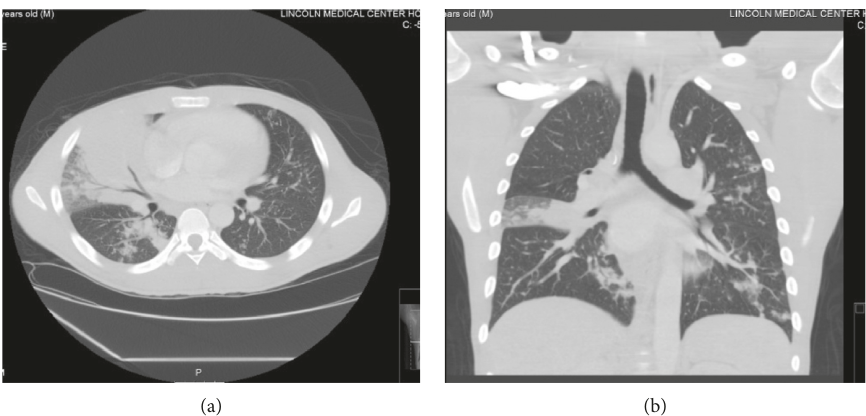
Figure 2: (a) CT chest (axial view) on the day of admission showing the right middle lobe consolidation with a possible necrotic medial segment and enlarged right hilar lymph nodes. (b) CT chest (coronal view) on the day of